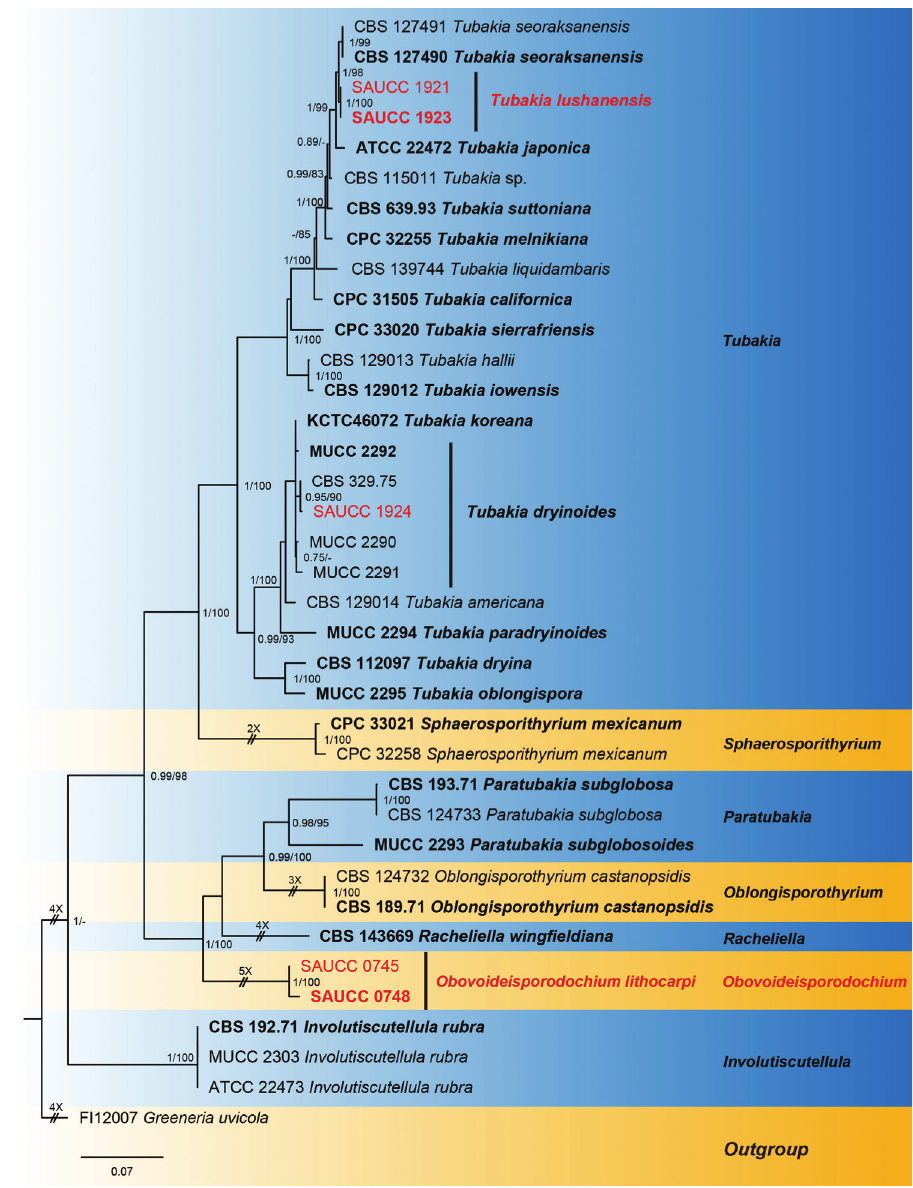
Figure 2. Phylogram of Tubakiaceae, based on the concatenated ITS, tef1 and tub2 sequence alignment. The BI and ML bootstrap support values above 0.74 and 74% are shown at the first and second position, respectively. The tree is rooted to Greeneria uvicola (culture FI12007) and ex-type cultures are indicated in bold face. Strains from the current study are in red. Some branches were shortened for layout purposes – these are indicated by two diagonal lines with the number of times a branch was shortened indicated next to the